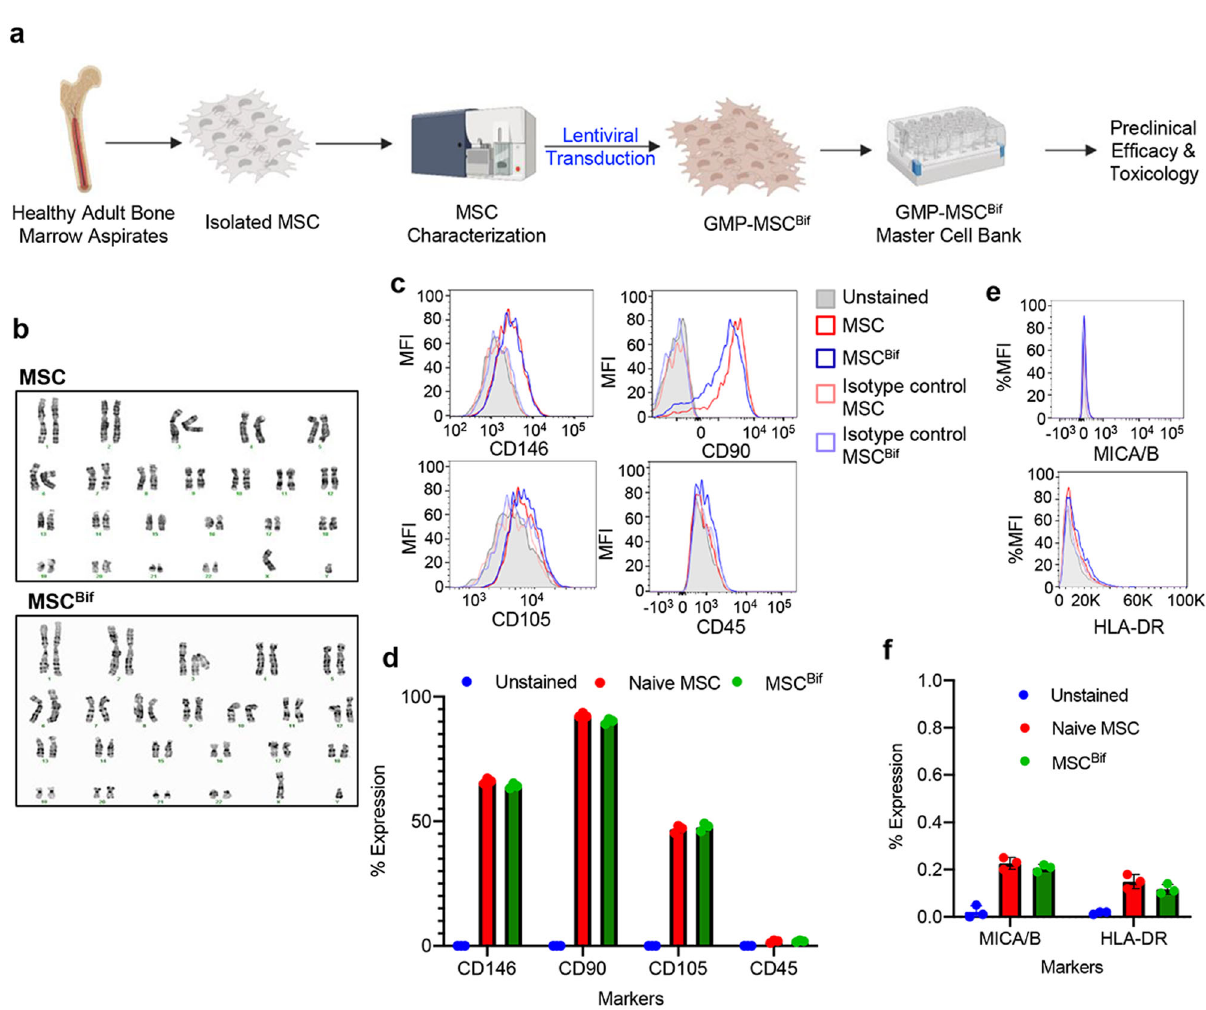
Fig. 3 Allogeneic MSC can be banked for “ off-the-shelf ” therapeutic use. a Illustration depicting the MSC isolation and banking process. b Conventional karyotype analysis of MSC Bif as compared with naive MSC showing no changes in the chromosomes post MSC transduction. c Plot showing surface expression analysis of naïve MSC and MSC Bif using expression markers CD146, CD90, CD105, and CD45 revealing distinct MSC identity of MSC Bif by fl ow cytometry. d Plot showing the quanti fi cation of various markers analyzed in c . e Immunogenicity pro fi ling plots for MHC Class I and II antigen markers of MSC and MSC Bif by fl ow cytometry. f Plot quantifying the immunogenicity pro fi ling represented in e . Data shown are an aggregate of three biologically independent experiments. Data are shown as mean ±